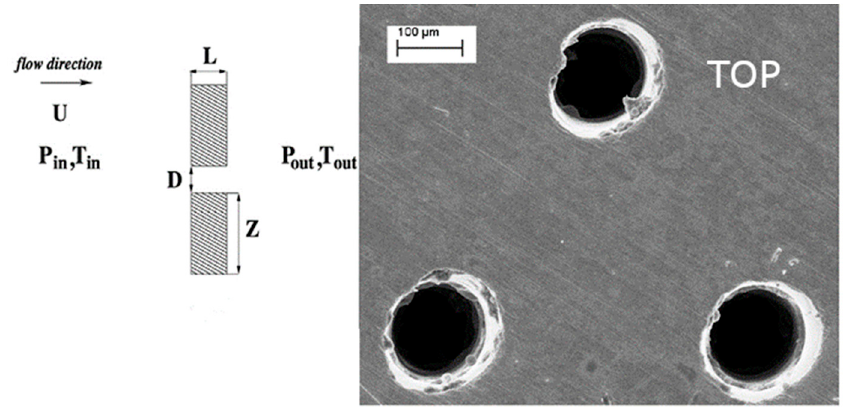
Figure 3. Schematic illustration of the perforated plate and the microscopic picture.